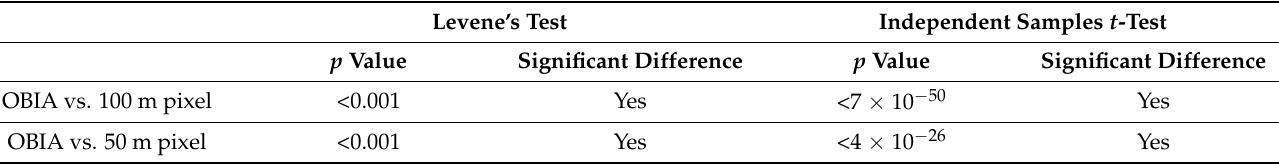
Table 10. Results of statistical tests. The test results are the comparison results with the object- based